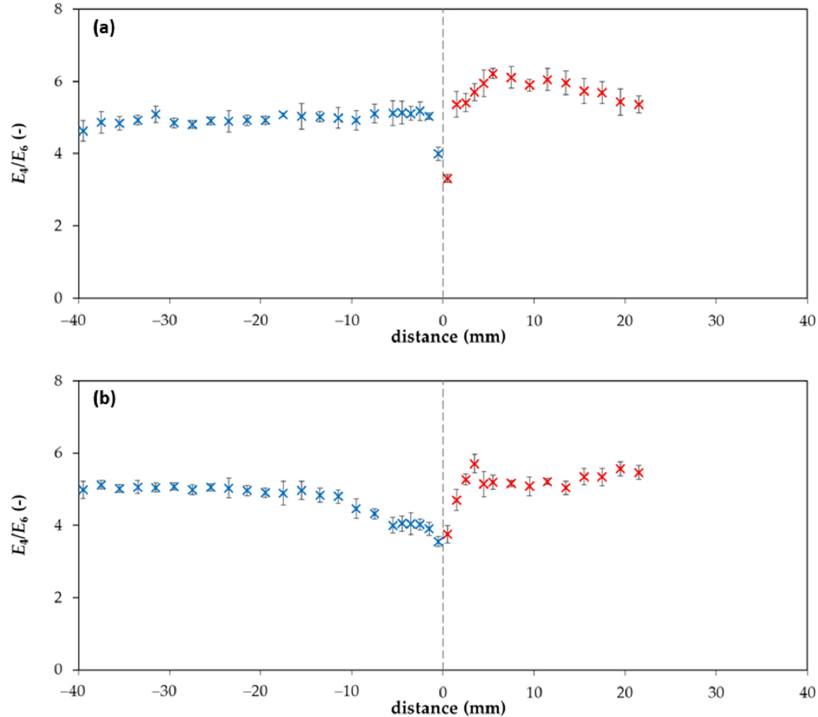
Figure 6. E 4 / E 6 ratio in agarose hydrogel after two ( a ) and ten ( b ) days. The blue points belong to the Figure 6 donor hydrogel (distance x < 0), while the red points belong to the acceptor hydrogel (distance x >